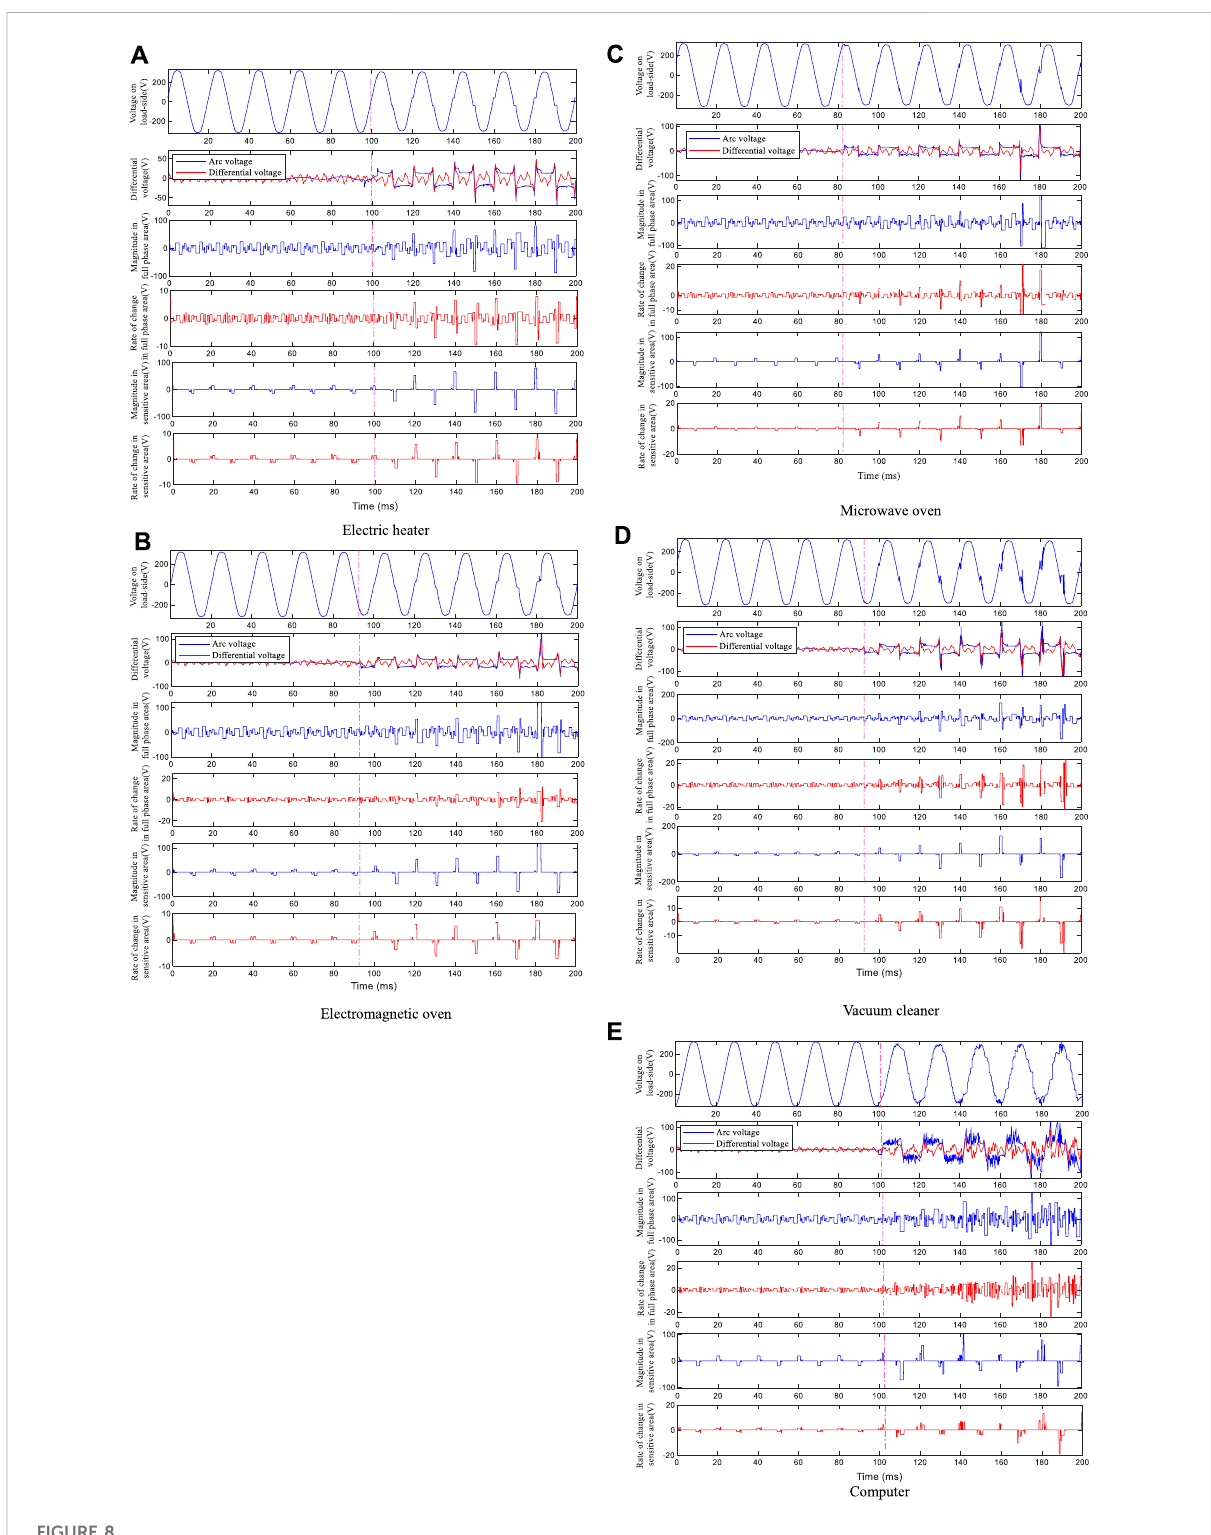
FIGURE 8 The identi fi cation results of the method (A) Electric heater (B) Electromagnetic oven (C) Microwave oven (D) Vacuum cleaner (E)